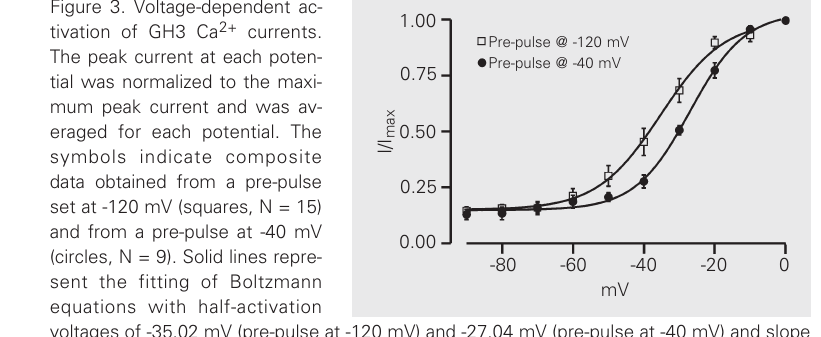
Figure 3. Voltage-dependent ac- tivation of GH3 Ca 2+ currents. The peak current at each poten- tial was normalized to the maxi- mum peak current and was av- eraged for each potential. The symbols indicate composite data obtained from a pre-pulse set at -120 mV (squares, N = 15) and from a pre-pulse at -40 mV (circles, N = 9). Solid lines repre- sent the fitting of Boltzmann equations with half-activation voltages of -35.02 mV (pre-pulse at -120 mV) and -27.04 mV (pre-pulse at -40 mV) and slope factors of 6.65 (pre-pulse at -120 mV) and 7.51 (pre-pulse at -40